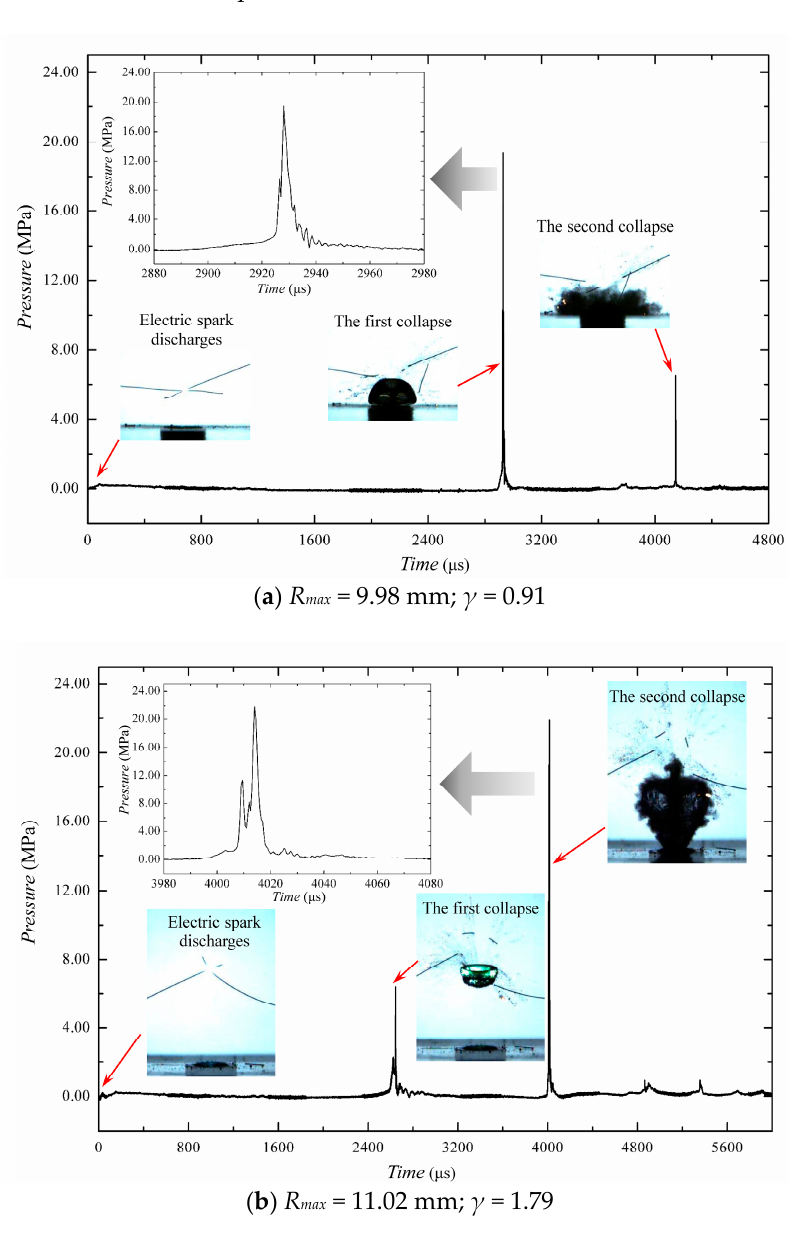
Figure 4. The impulsive process generated by cavitation bubble collapse for ( a ) γ = 0.91; ( b ) γ = 1.79.